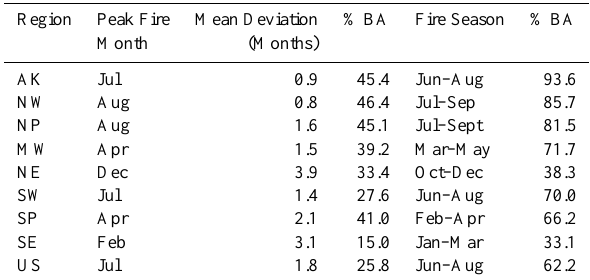
Table 1. Peak fire month, 3-month fire season, and the fraction of mean annual GFED BA in these months for each study region. The mean deviation in peak fire month highlights the heterogeneity of fire activity within each